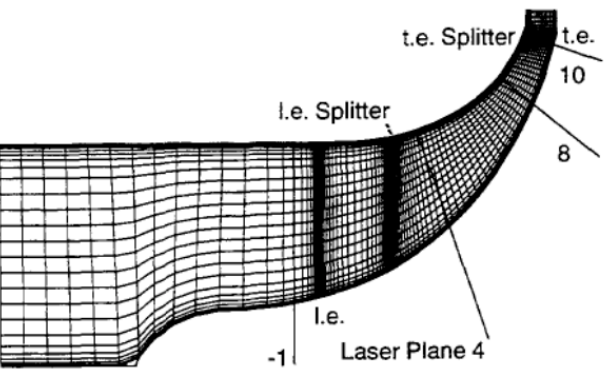
Figure 8. The experimental laser measurement planes in the compressor passage.